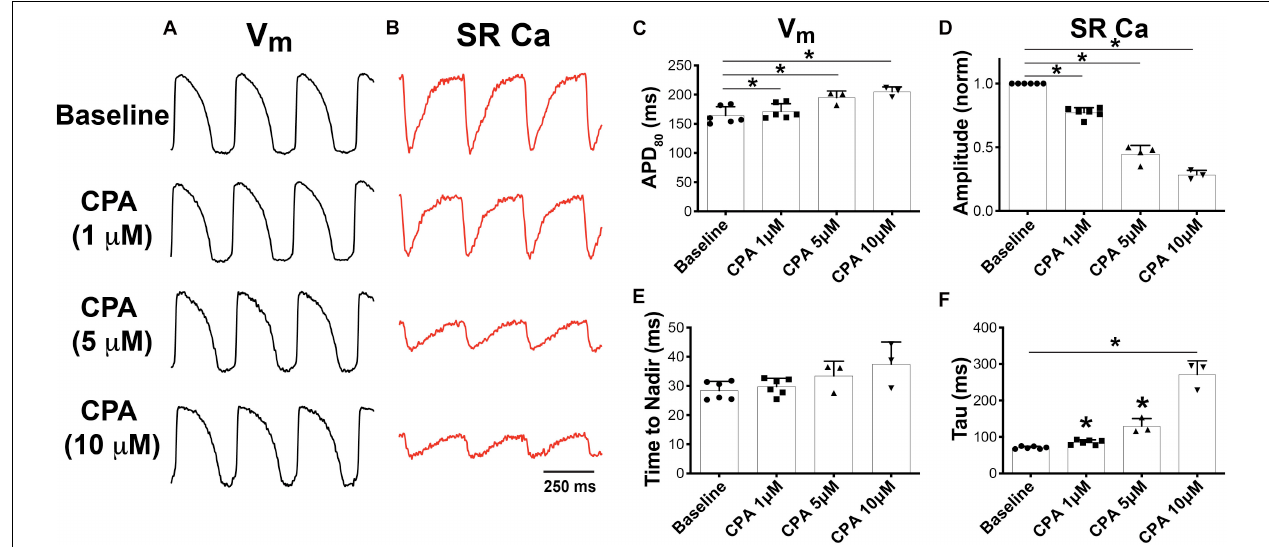
FIGURE 1 | Dual optical mapping of V m (A) and sarcoplasmic reticulum (SR) Ca 2 + (B) during sarco-endoplasmic reticulum Ca 2 + -ATPase (SERCA) inhibition with cyclopiazonic acid (CPA) and pacing at a pacing cycle length (PCL) of 300 ms. CPA caused a dose-dependent increase in APD 80 (C) and decrease in normalized SR Ca 2 + transient amplitude (D) . CPA tended to prolong the time to nadir of SR Ca 2 + release (E) and significantly prolonged SR Ca 2 + reuptake time ( tau , F ). Mean ± SD. N = 3–6 (* p < 0.05 vs. baseline).